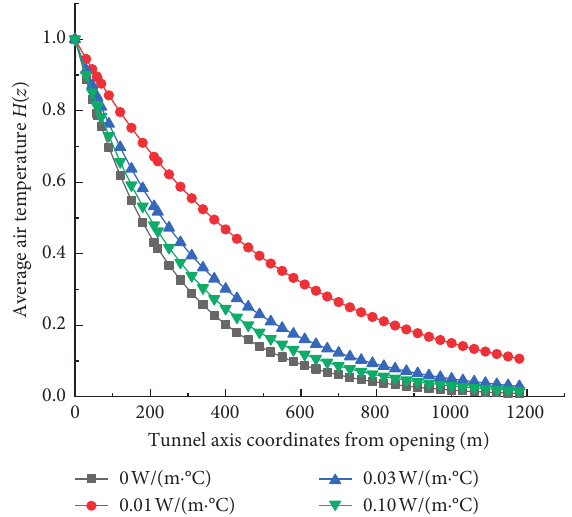
Figure 6: Comparison of the mean temperature function, H ( z ), of the tunnel under different insulation